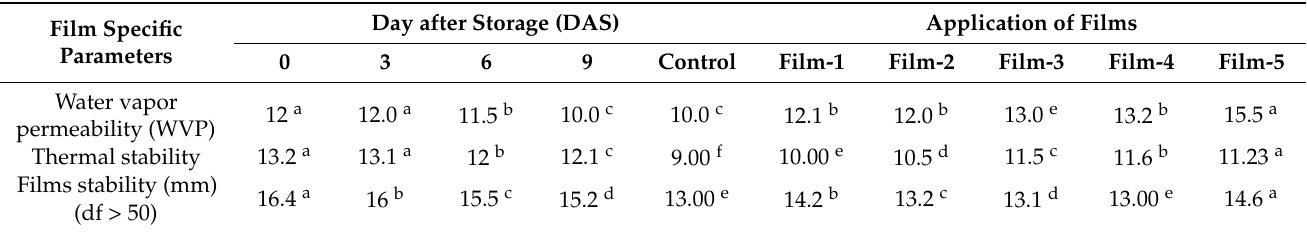
Table 3. Comparison of film stability parameters.